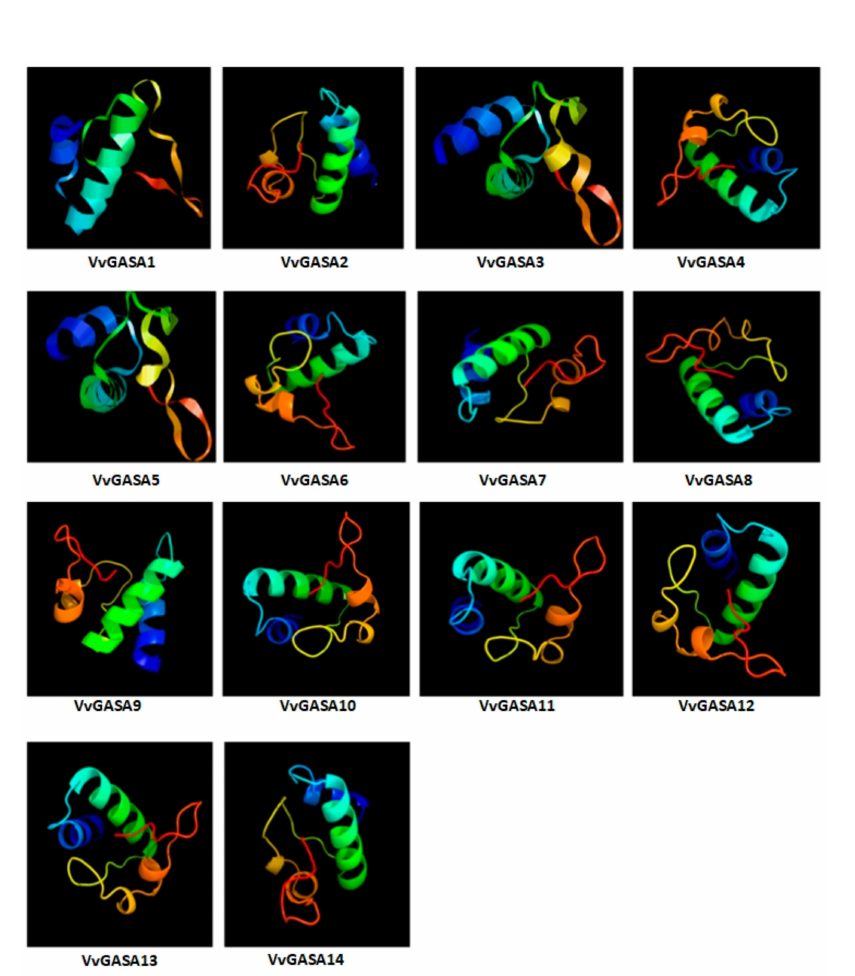
Figure 1. Predicted 3-D structures of GASA